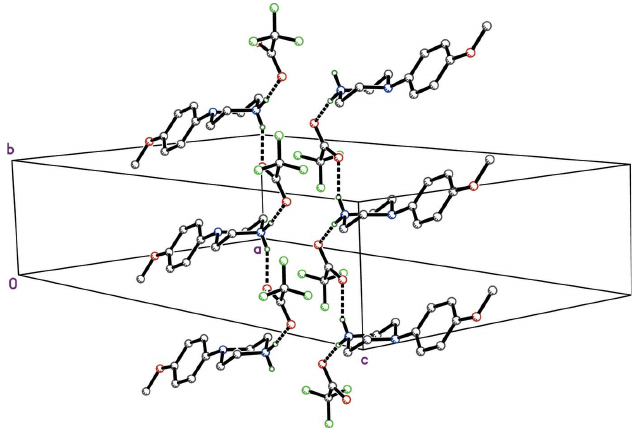
Figure 6 A partial packing plot of I showing hydrogen-bonded chains (solid dashed lines) parallel to the b -axis. Hydrogen atoms not involved in hydrogen bonds are omitted.